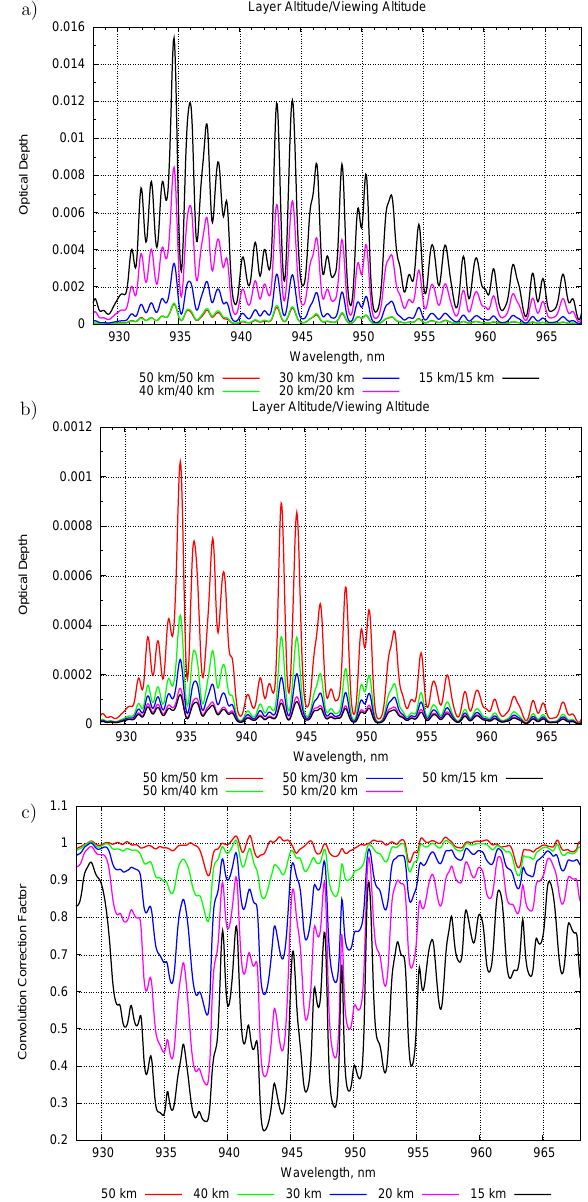
Fig. 2. Modelled partial optical depths (including convolution cor- rection). The “layer altitude” is the only altitude containing water vapour. The “viewing altitude” corresponds to the observed tan- gent altitude. (a) Layer altitude equals viewing altitude. (b) Same layer altitude (50km) but different viewing altitudes. (c) Convolu- tion correction factor as function of wavelength for different tangent